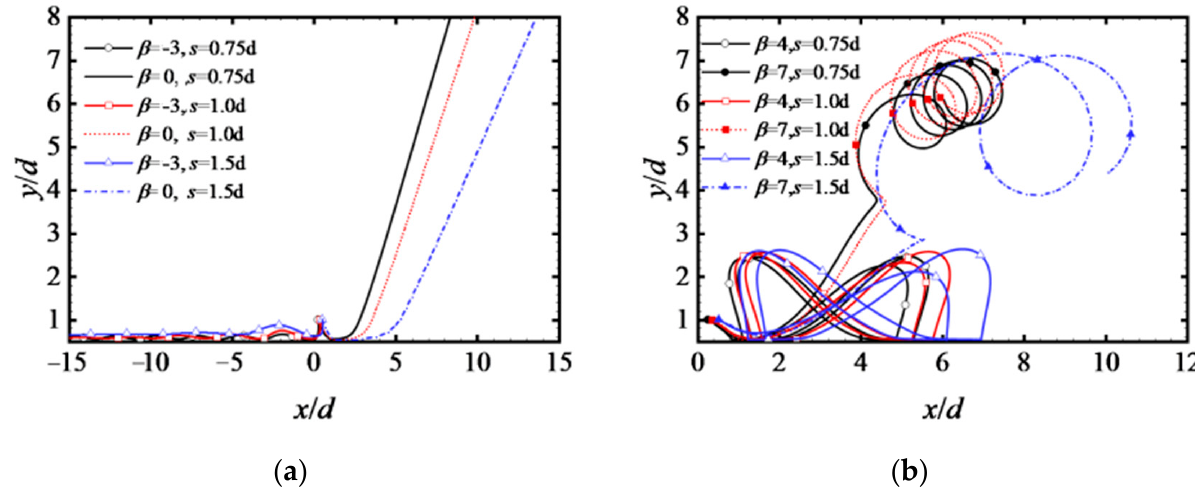
Figure 13. Trajectory of rod-shaped squirmers with different values of s ( Re s = 0.5, i = 2): ( a ) β = − 3 and β = 0; ( b ) β = 4 and β = 7.